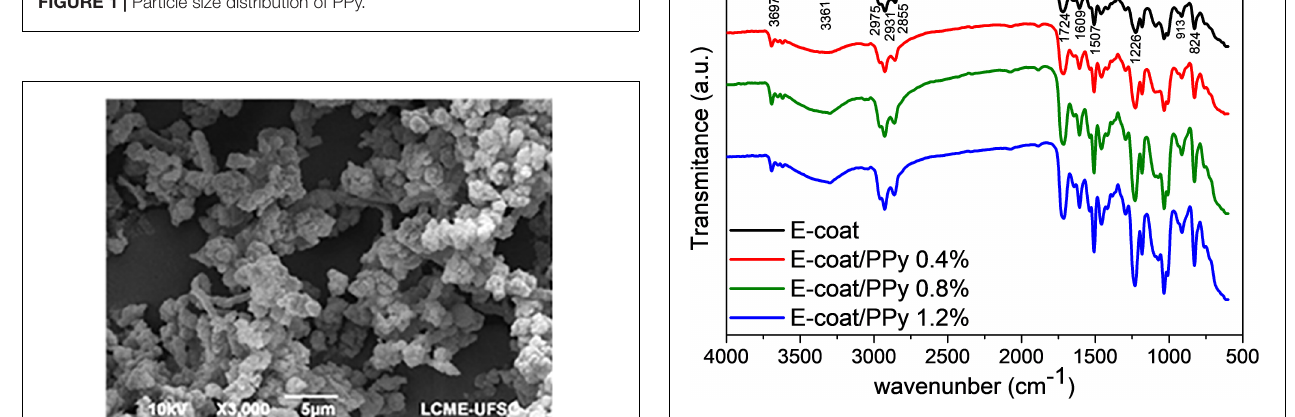
FIGURE 1 | Particle size distribution of PPy.